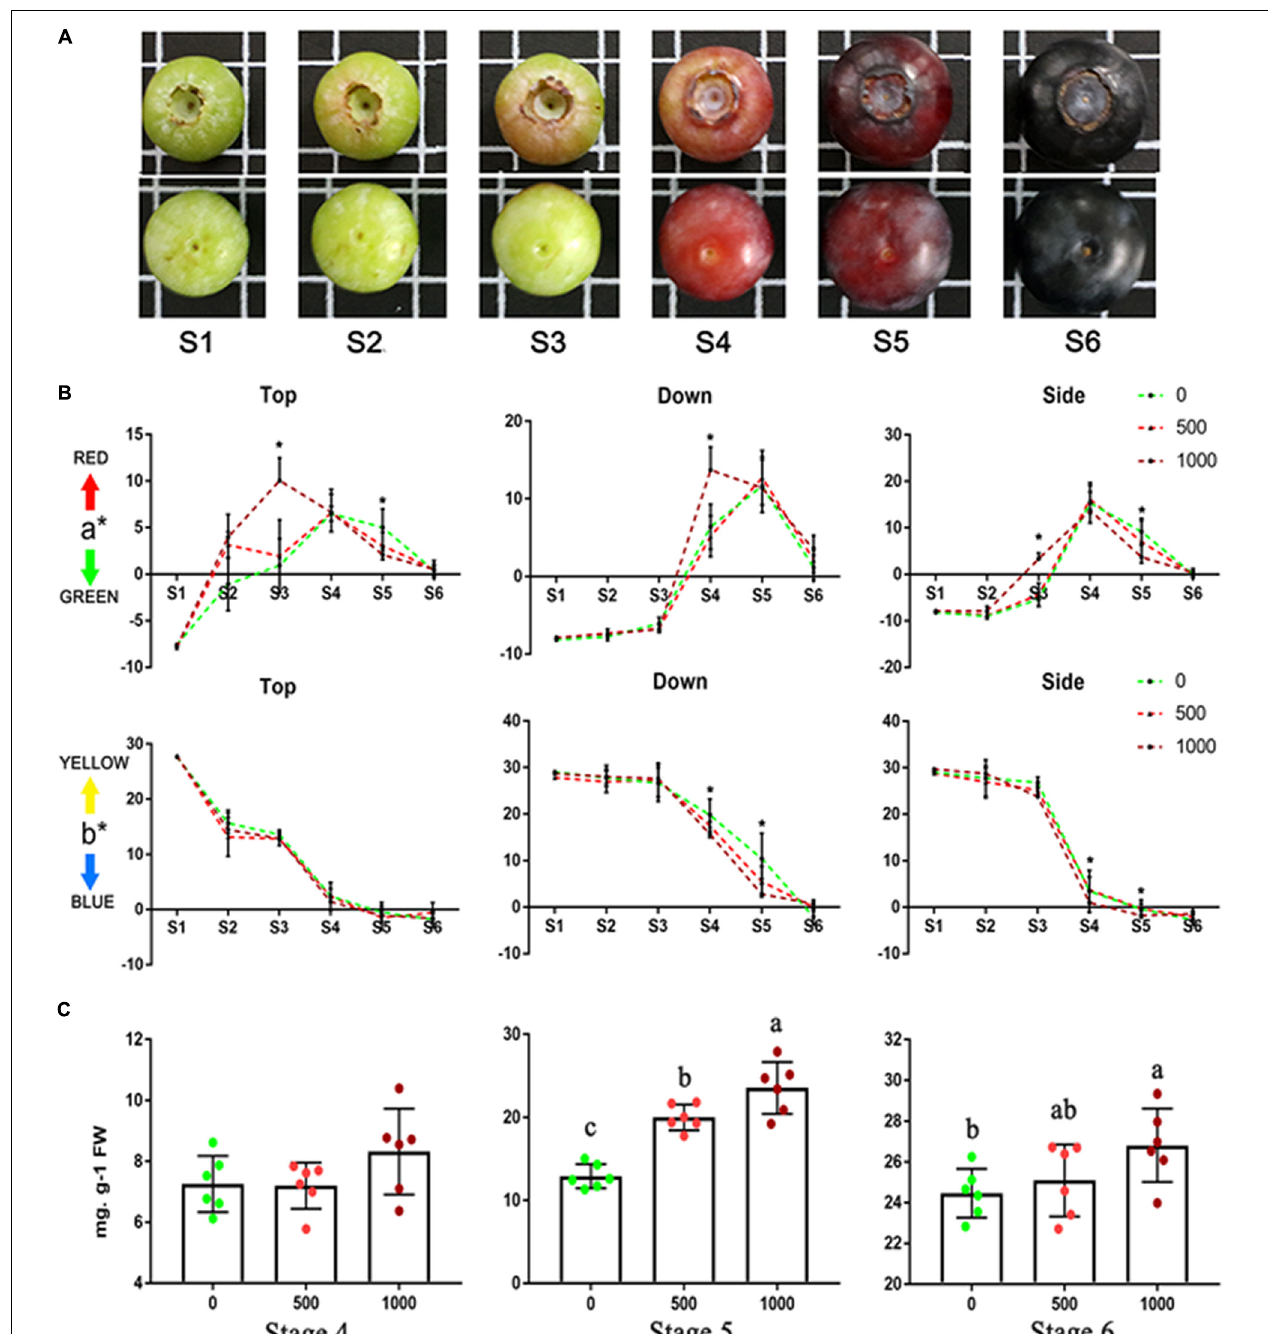
FIGURE 1 | Ripening progress of blueberry (cv “Brightwell”) and coloration and anthocyanins content of fruits under 0, 500, and 1,000 mg/L ABA treatment. (A) The ripening progress is divided into six stages. (B) The color of top, side and bottom of fruits from S1 to S6. (C) Total anthocyanins content from S4 to S6. Different letters and asterisk indicate statistical significance ( P < 0.05) as determined by a one-way ANOVA test (Duncan’s multiple